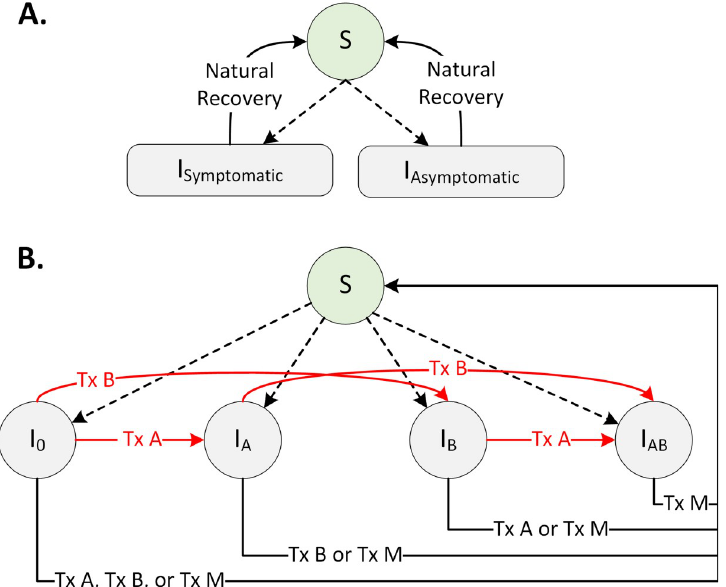
Fig 1. A stochastic gonorrhea transmission model. Dotted arrows represent new infection, and red arrows represent resistance acquisition while under treatment. S represents susceptibles, I 0 represents drug-susceptible infections, and I A , I B , and I AB represent infections resistant to drug A, drug B, and both. Tx A, Tx B, and Tx M denote treatment with drugs A, B, and M. The expanded model structure is displayed in S1 Fig in S1 Text. The model is adapted from [15], with additional details necessary to evaluate the strategies in Table